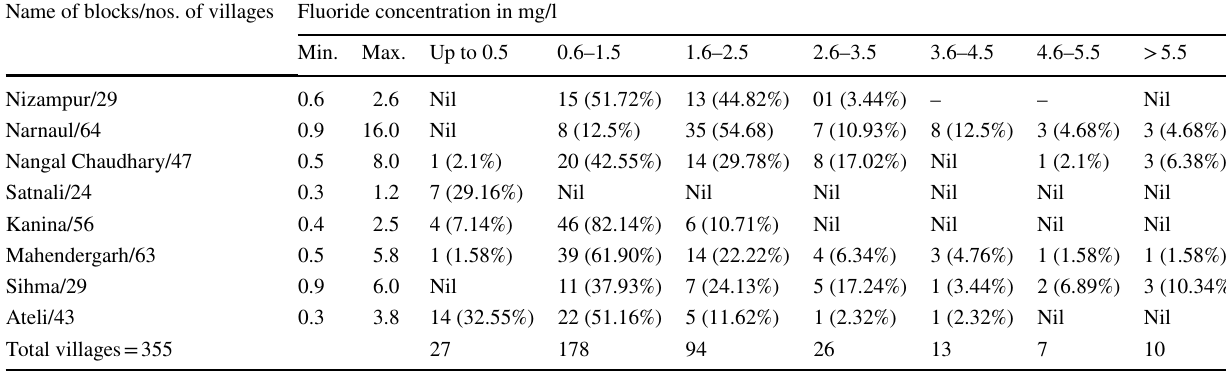
Fig. 3 Fluoride concentration in underground water of different blocks of